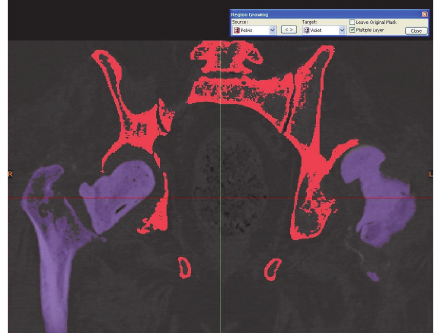
Figure 6: Thresholding of the pelvis and femoral